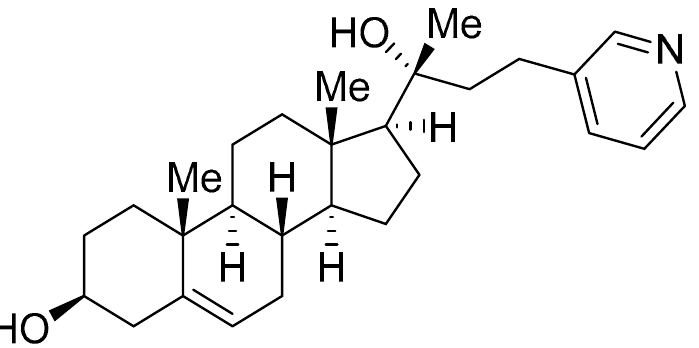
Figure 9. Molecular formula of Oxy210.